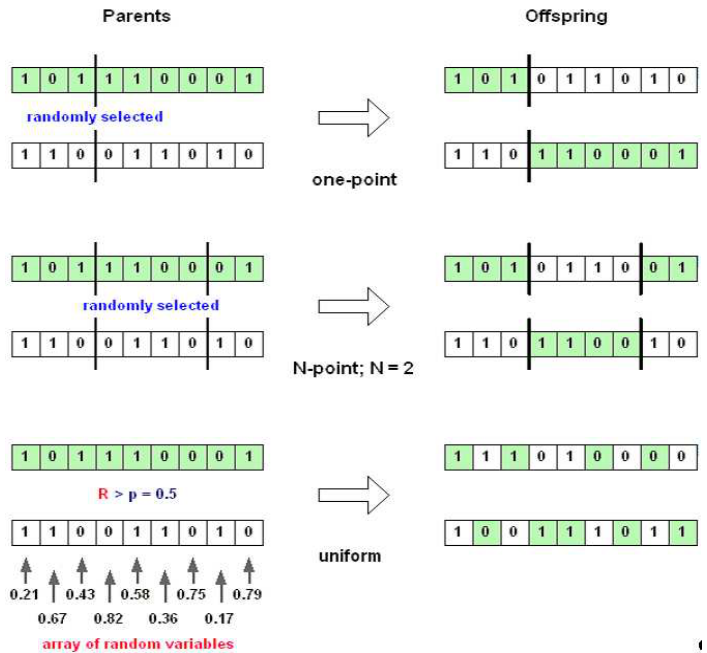
Figure 11. Types of discrete